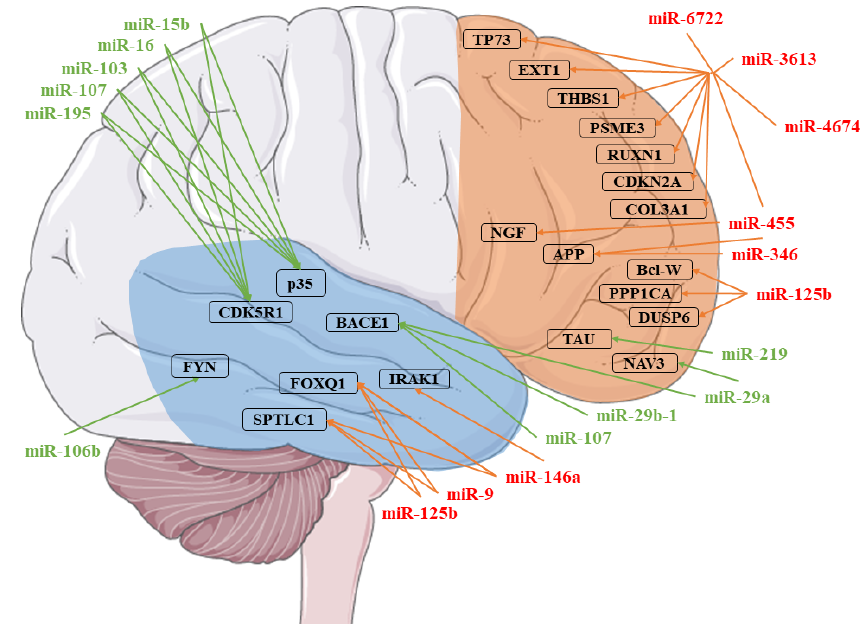
Figure 1. Representation of the microRNAs (miRNAs) involved in Alzheimer’s disease (AD). Each miRNA identified was associated with its targets. The miRNAs in red were found to be upregulated, while those in green are downregulated. The targets are identified in the temporal (blue) or the frontal (orange) cortex [5–16]. The figure was drawn using the vector image bank of Servier Medical Art by Servier (http://smart.servier.com/). Licensed under a Creative Commons Attribution 3.0 Unported License (https://creativecommons.org/licenses/by/3.0/).